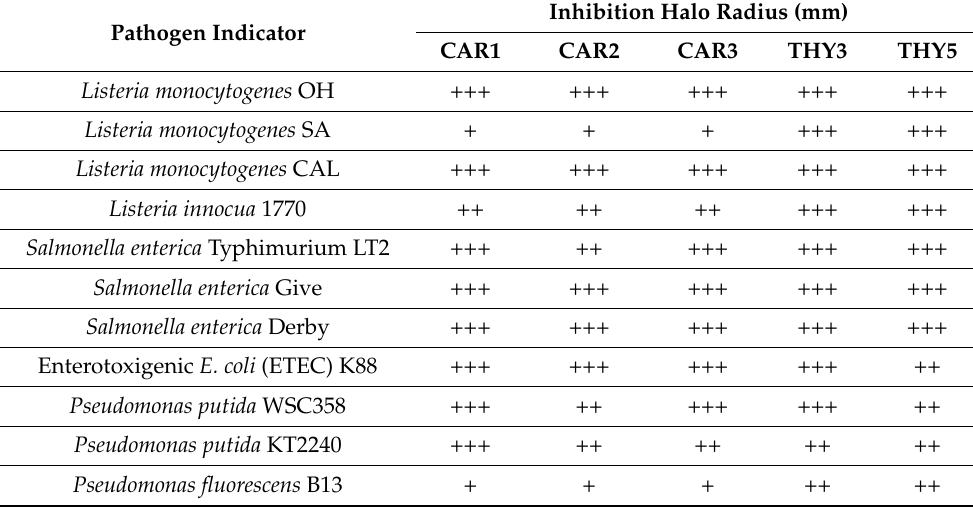
Table 3. Antimicrobial activity of oregano EOs against indicator pathogens (spot test). Inhibition Halo Radius (mm) Pathogen Indicator CAR1 CAR2 CAR3 THY3 THY5 Listeria monocytogenes OH +++ +++ +++ +++ +++ Listeria monocytogenes SA + + + +++ +++ Listeria monocytogenes CAL +++ +++ +++ +++ +++ Listeria innocua 1770 ++ ++ ++ +++ +++ Salmonella enterica Typhimurium LT2 +++ Salmonella enterica Give Salmonella enterica